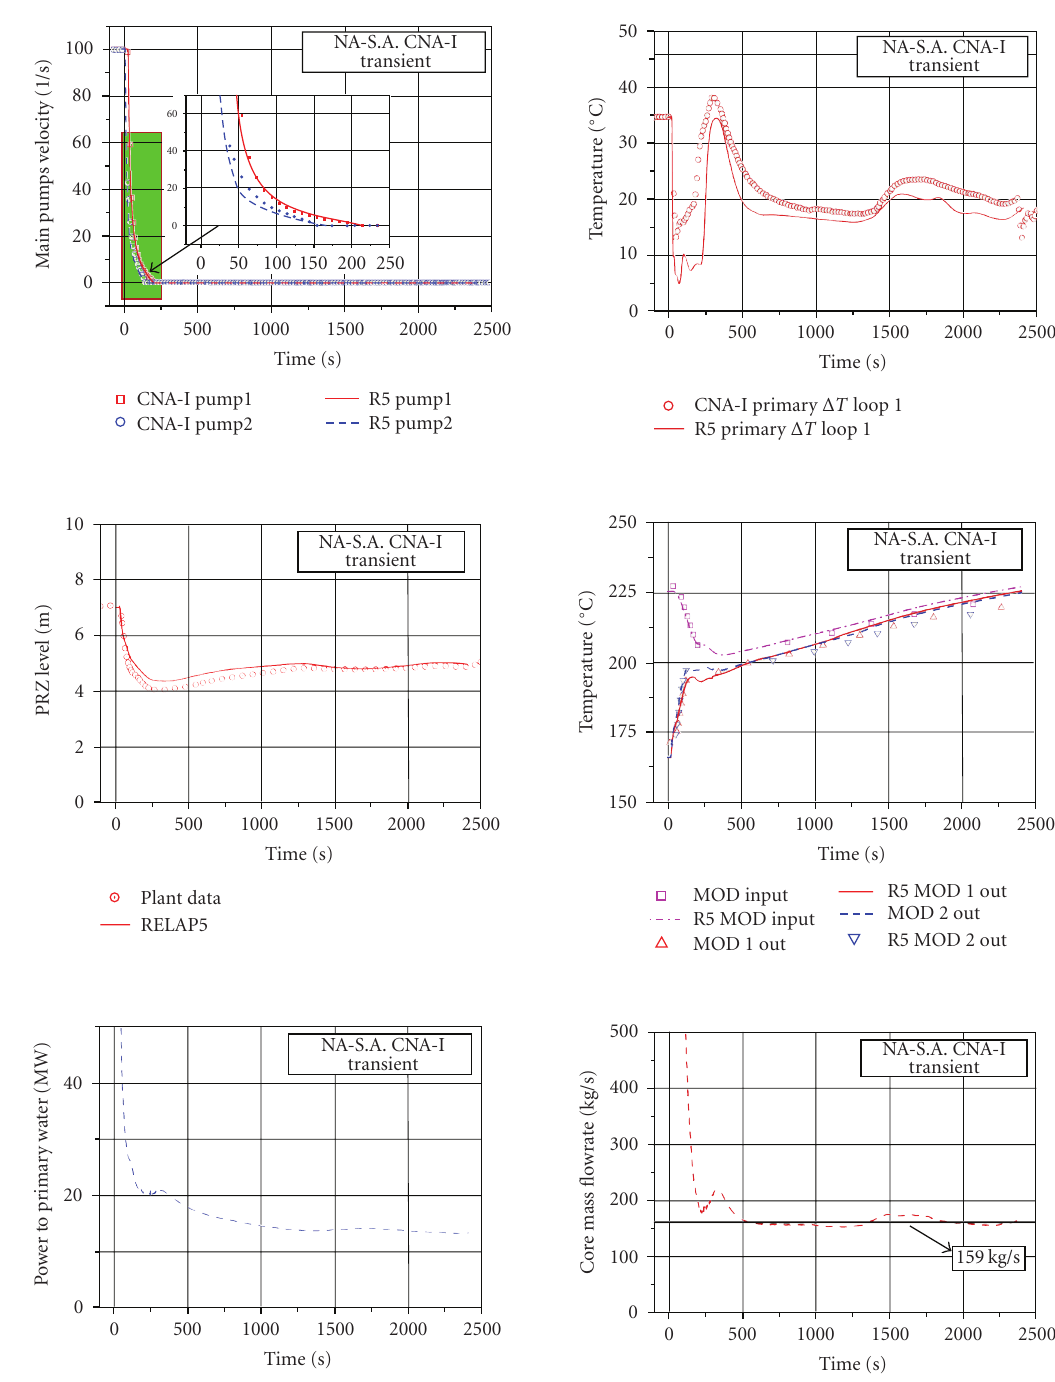
Figure 7: Simulation of an NC transient in the